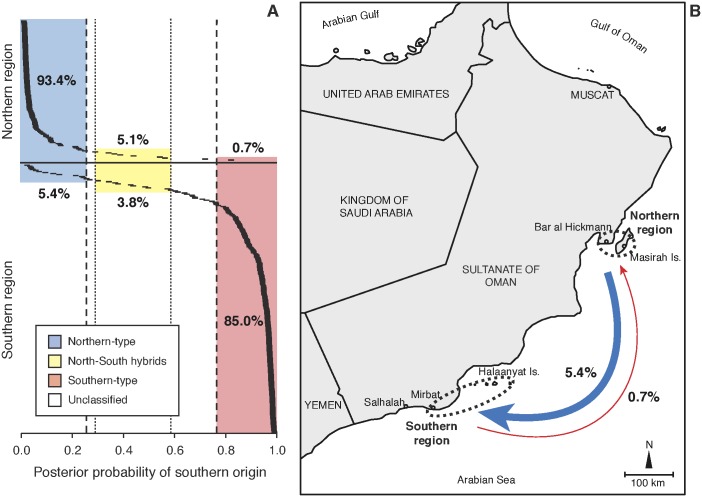
Long-distance dispersal of the Omani clownfish.(a) Bayesian clustering analysis identified individuals that had migrated to distant populations over 400 km from their natal origins. Dashed lines indicate the thresholds of assignment of individuals to northern and southern types. Dotted lines indicate the thresholds of assignment of individuals as north-south hybrids. Percentage values indicate proportion of assigned individuals to different types in each region. (b) The southern Omani coastline has two regions of coral reefs separated by over high exposure sandy shores. The Indian summer monsoon is the main driver of both atmospheric and oceanic regimes causing strong southeasterly winds during summer months (the Khareef monsoon), which then reverse to weaker northeasterly winds during the winter monsoon. These current regimes favour southward dispersal of the Omani clownfish.